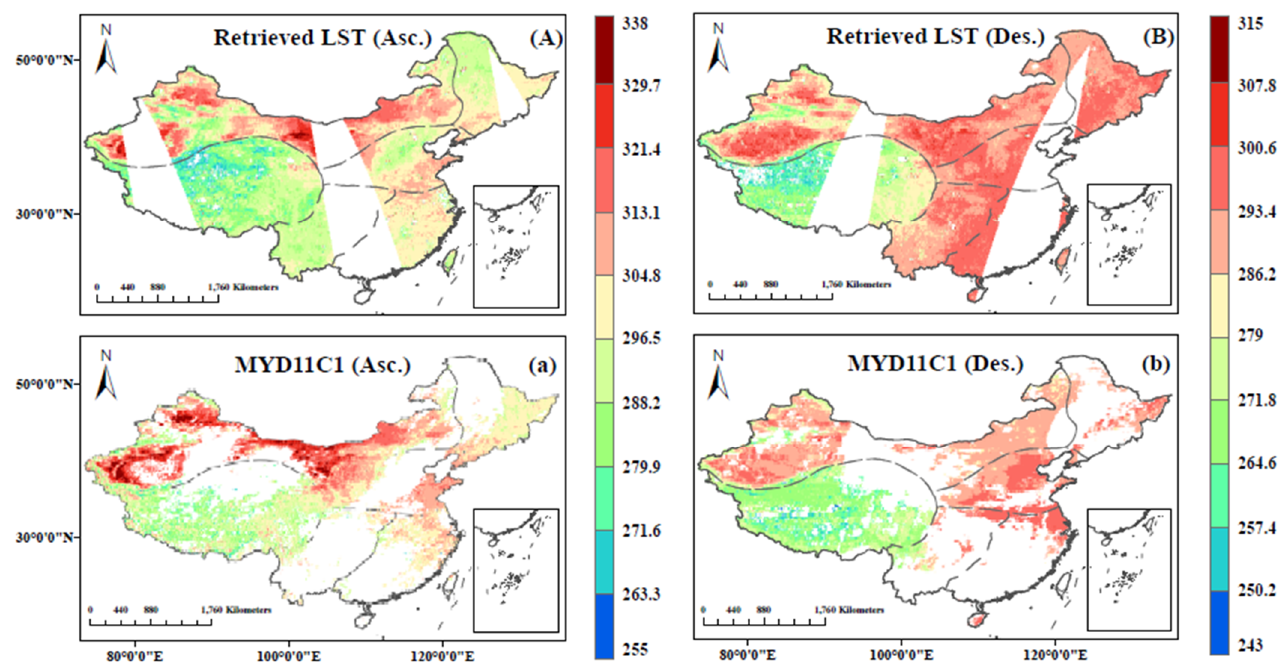
Figure 6. The LST (K) retrieved by the MDK-CR method: ( A ) ascending and ( B ) descending orbits. MODIS LST products: ( a ) ascending and ( b ) descending orbits.